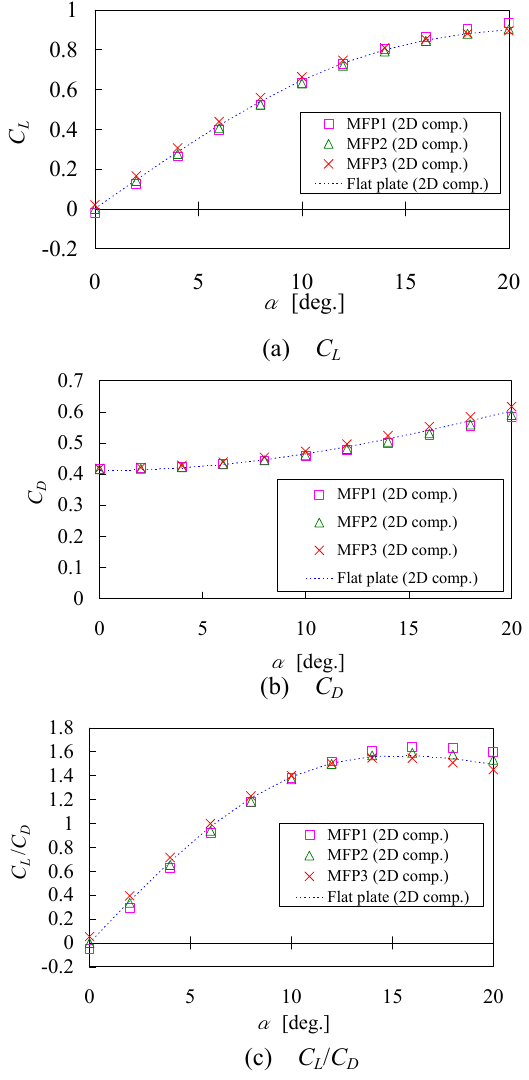
Fig. 12 Aerodynamics characteristics versus α at Re =1.0×10 2 (MFP1, MFP2 and